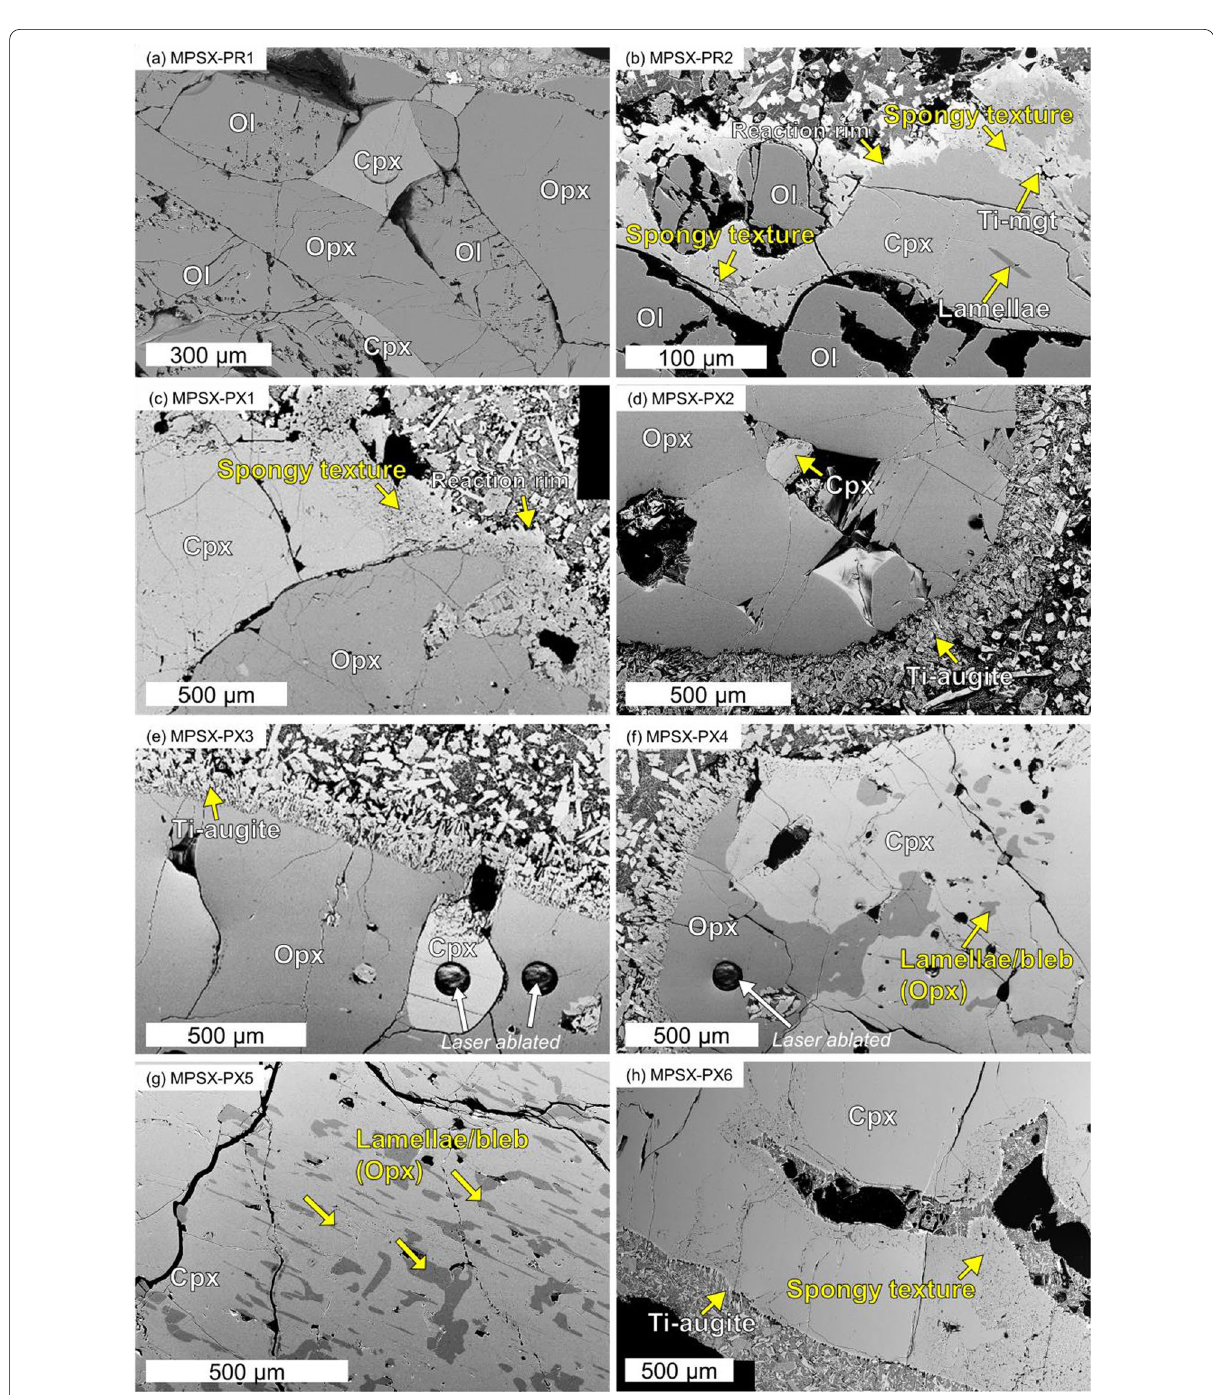
Fig. 3 Scanning electron microscope images of the samples. a MPSX-PR1 peridotite, b MPSX-PR2 peridotite, c MPSX-PX1 pyroxenite, d MPSX-PX2 pyroxenite, e MPSX-PX3 pyroxenite, f MPSX-PX4 pyroxenite, g MPSX-PX5 pyroxenite, and h MPSX-PX6 clinopyroxene